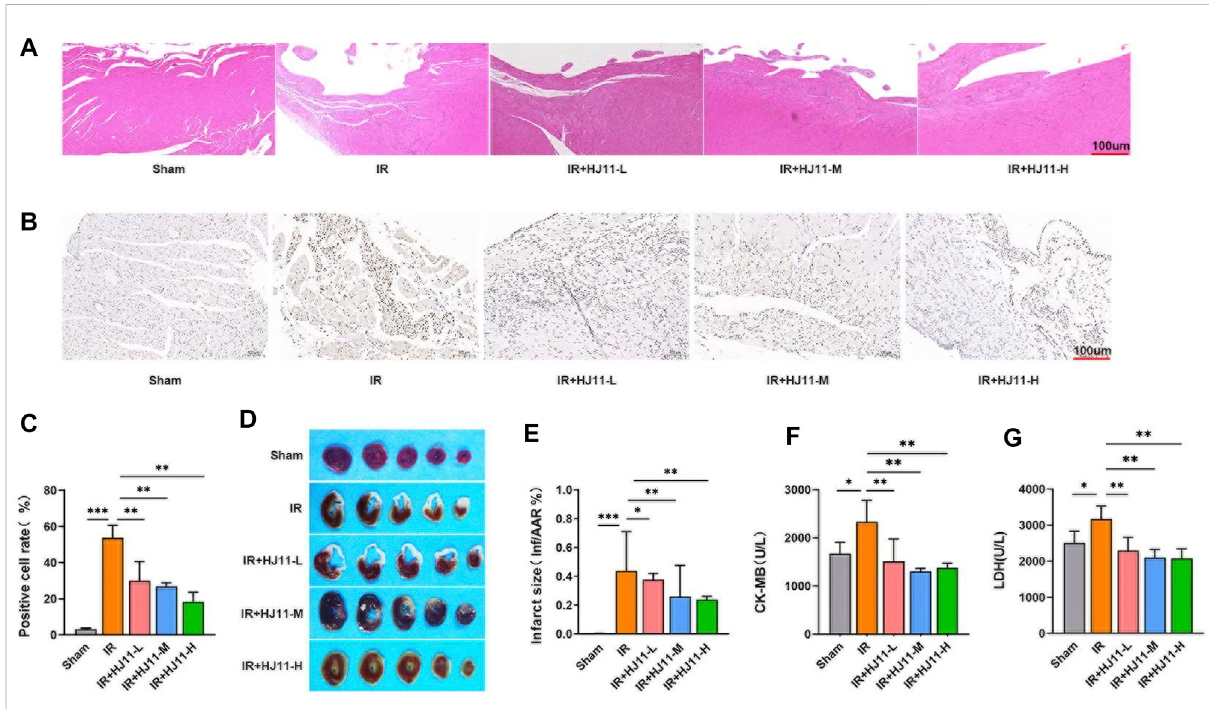
Effect of HJ11 decoction on myocardial I/R injury in the rat model. (A) Hematoxylin-eosin staining showing that HJ11 decoction reduced myocardial tissue injury in rats with myocardial ischemia-reperfusion (I/R) injury. Scale bar: 100 µm. (B,C) Terminal deoxynucleotidyl transferase dUTP nick end labeling (TUNEL) staining and statistical analysis of TUNEL-positive cells indicated that HJ11 decoction alleviated apoptosis in the myocardial tissues of rats with myocardial I/R injury. Scale bar: 100 µm. (D,E) 2,3,5-Triphenyltetrazolium chloride (TTC) staining of myocardial tissues and statistical analysis suggested that HJ11 decoction reduced the infarct size of rats with myocardial I/R injury. (F,G) HJ11 decoction decreased the levels of creatine kinase – MB (CK-MB) and lactate dehydrogenase (LDH) in the serum of rats. * p < 0.05. ** p < 0.01. *** p < 0.001. Data are shown as mean ± standard deviation. N = 3 – 6 rats for each